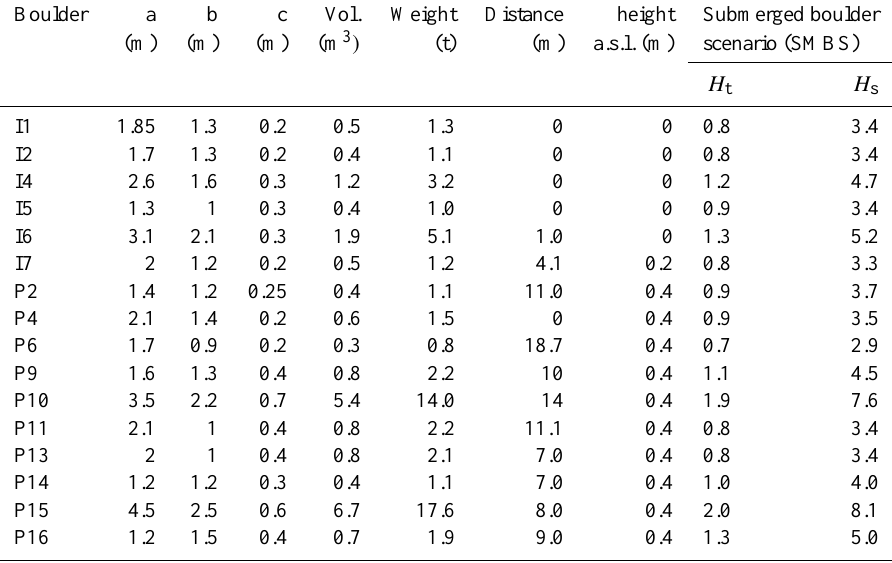
Table 1. Structural features of the 32 boulders showing an axis ≥ 1m and relative H s and H t values calculated with the hydrodynamic equations (Benner et al., 2010; Pignatelli et al.,